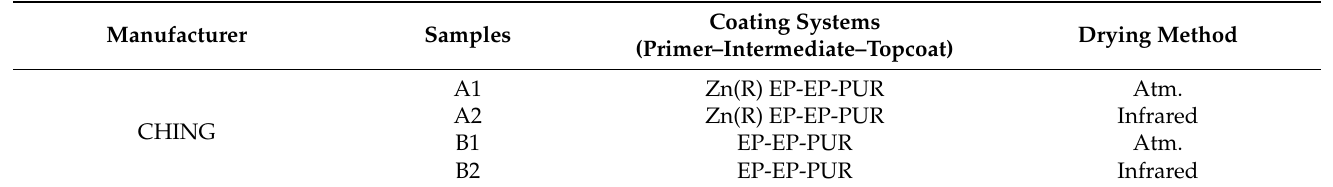
Table 2. Steel test plates with regard to the primer type, drying method, and manufacturer.